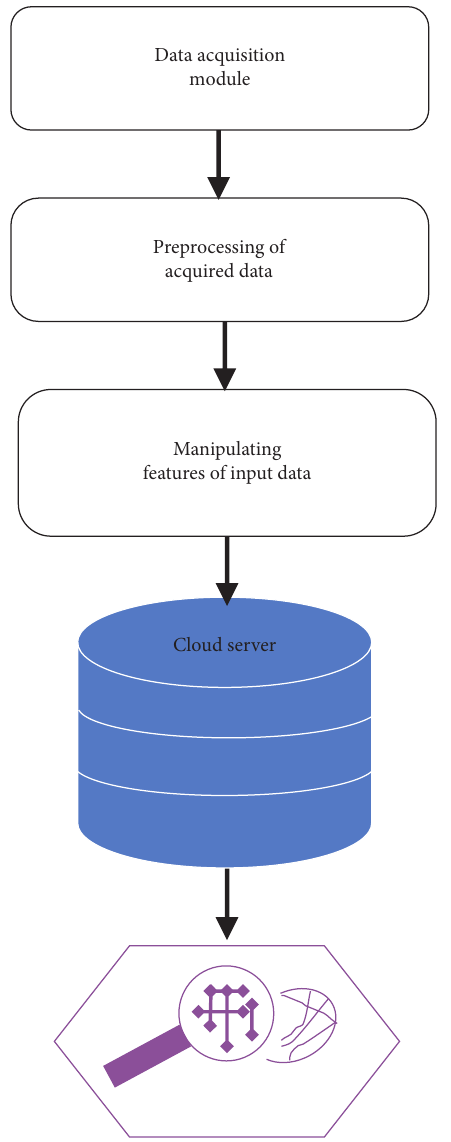
Figure 4: Diagram of the proposed